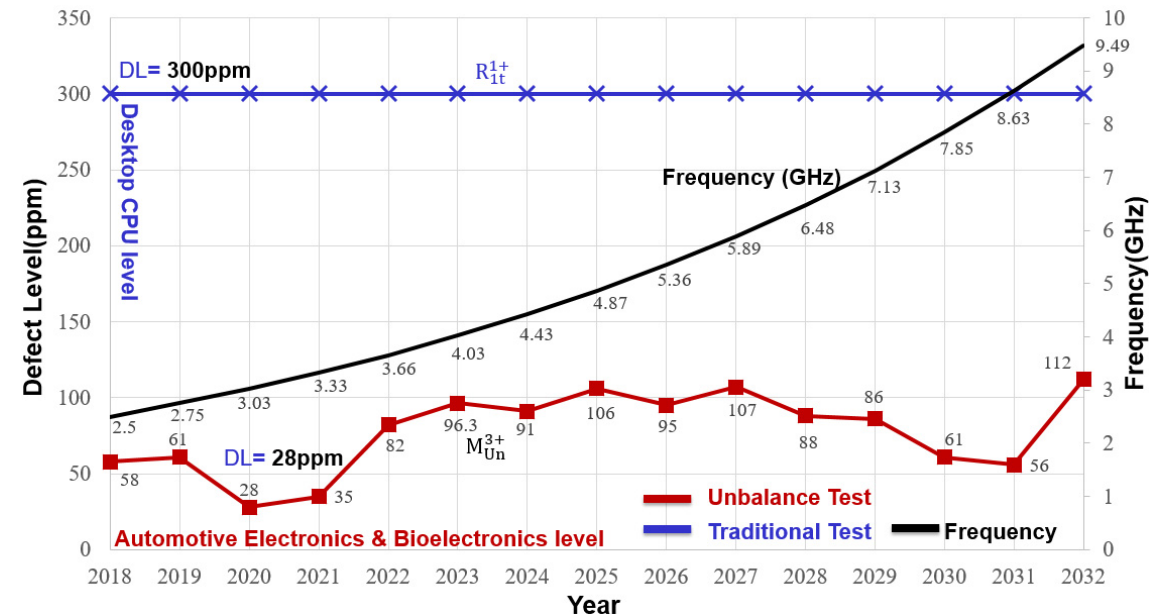
Figure 7. Methods used to estimate the test quality under same test yield conditions.